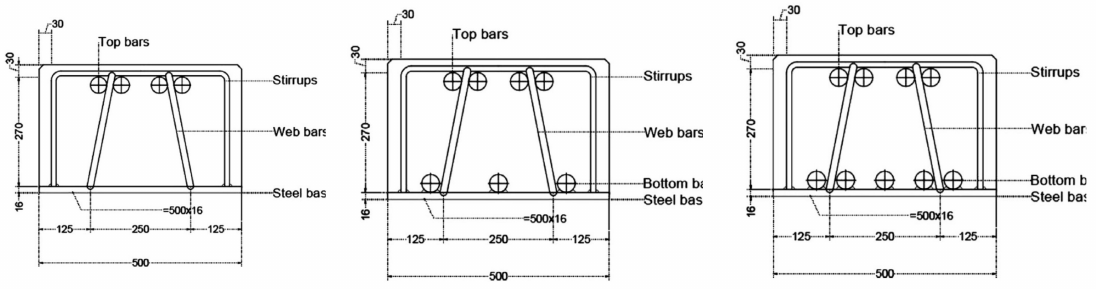
Figure 15. Cross-sections of the three typologies of tested beams (Chisari and Amadio [16]). The beams were simply supported at the ends and loaded with a concentrated force asymmetrically applied with respect to the midspan. The tests were performed in displacement control. The scheme of the geometry and the load condition is represented in Figure